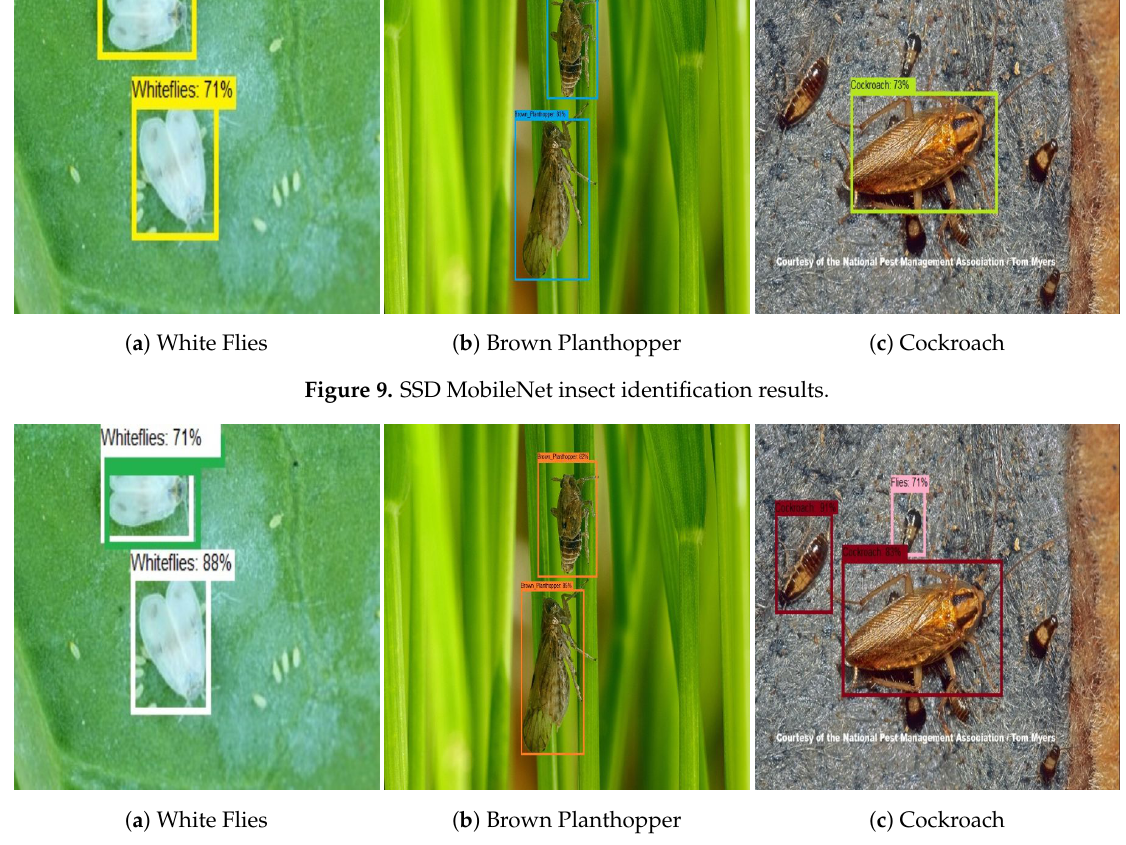
Figure 10. SSD inception insect identification results.